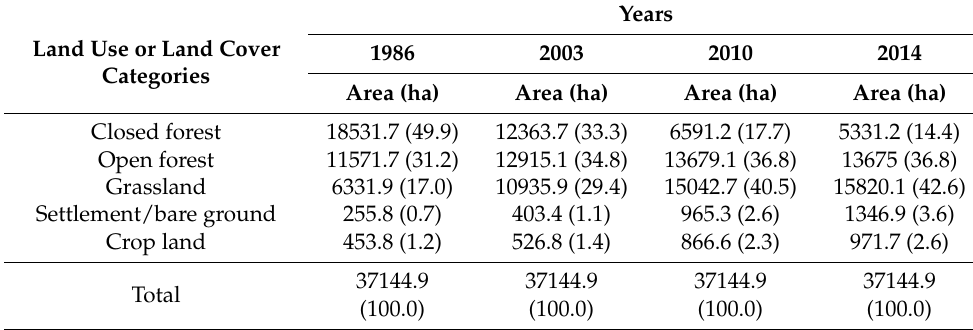
Table 8. Land use and distribution cover of Bobiri forest reserve for 1986, 2003, 2010 and 2014.